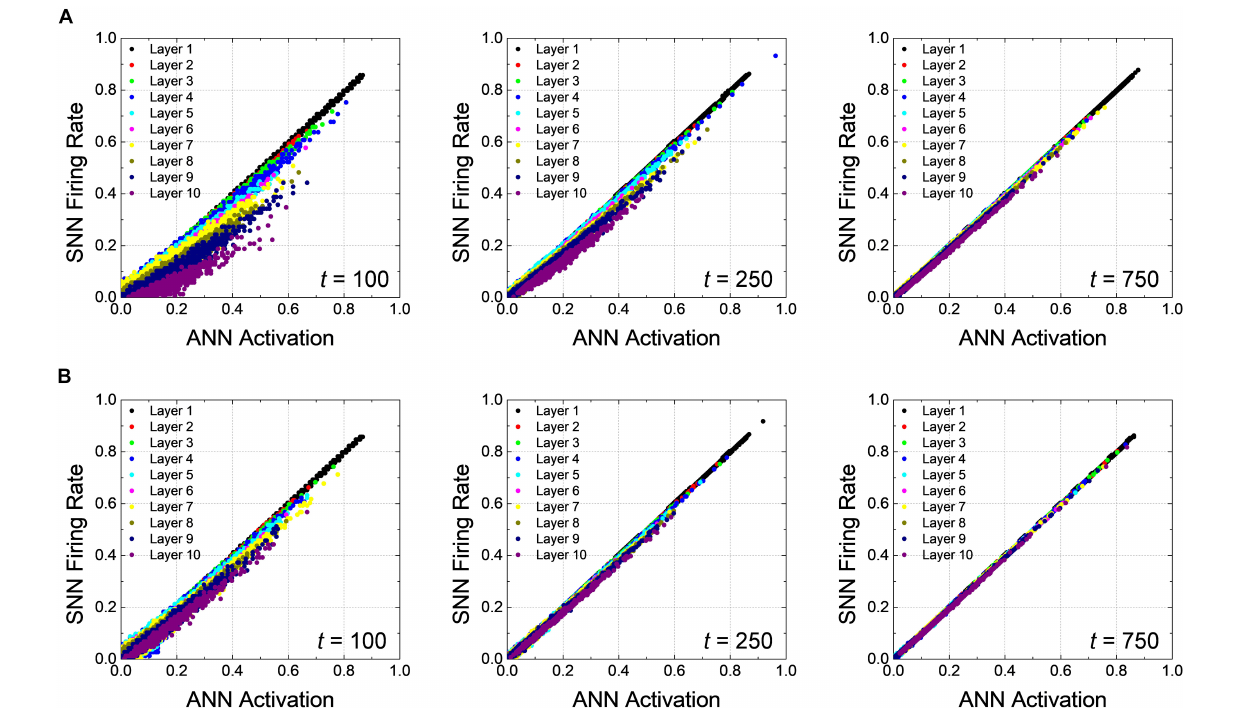
FIGURE 6 | Correlation diagrams of Net 2 at 100, 250, and 750th timesteps for the global V pc of (A) 0.0 and (B) 0.3. In a deep network, the latency is more clearly seen compared with the case of Net 1 .